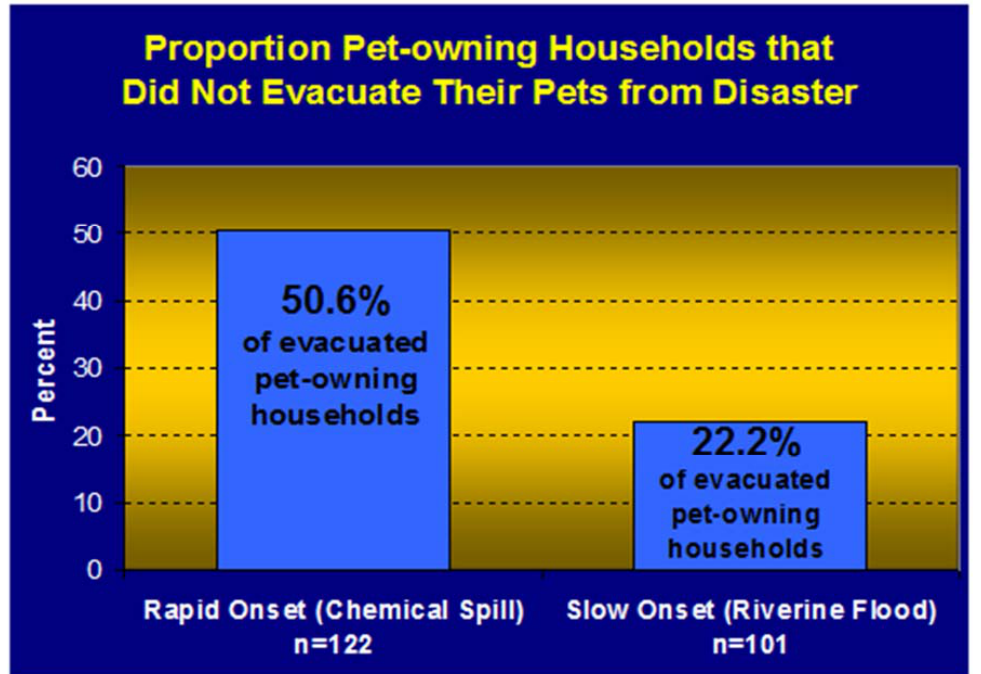
Figure 4. Proportion of pet-owning households that did not evacuate their pets from a slow and a rapid onset disaster [25,26].